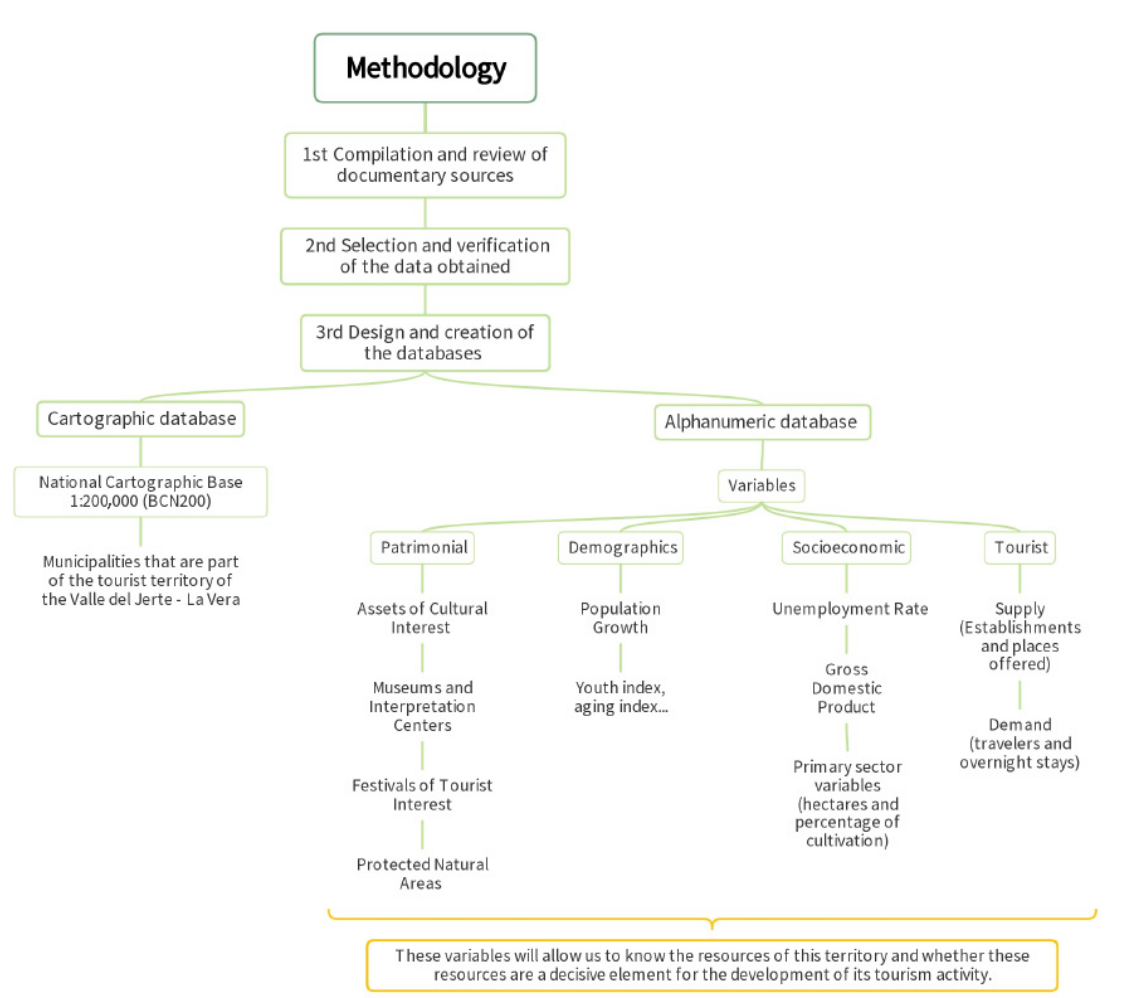
Figure 2. Methodological scheme.